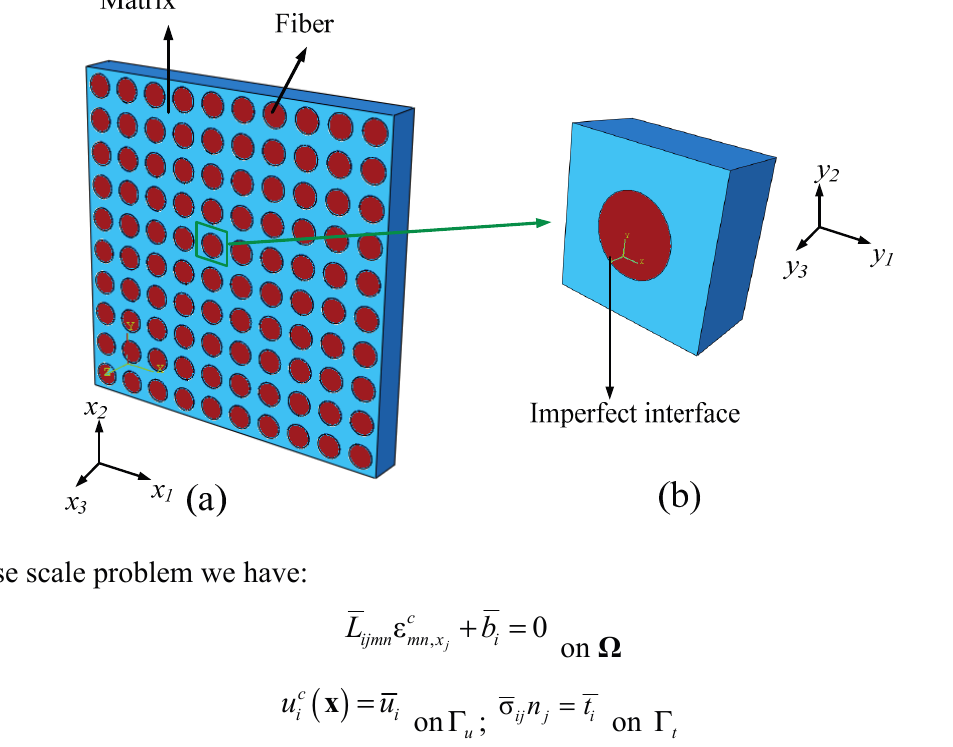
Figure 11. ( a ) Sketch of fiber-reinforced ceramic matrix composites; and ( b ) an enlarged 3D unit